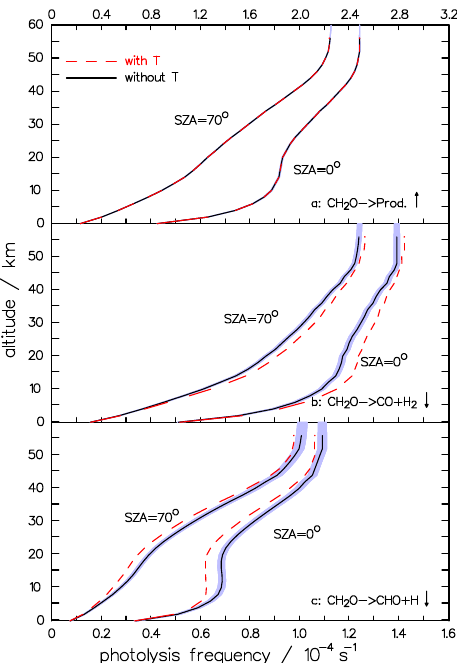
Figure 5. Impact of a temperature-dependent quantum yield, (cid:56) rad , on the altitudinal profile of the photolysis of formaldehyde: total photolysis (a) , molecular channel (b) , and radical channel (c) . The dashed line indicates the impact of the temperature dependence of (cid:56) rad given by Troe (2007). The shaded areas mark the 1 σ error bounds of the profiles based on the errors of the fitting parameters for the present quantum yields. The frequencies are depicted for two solar zenith angles (SZA). (The arrows point to the related